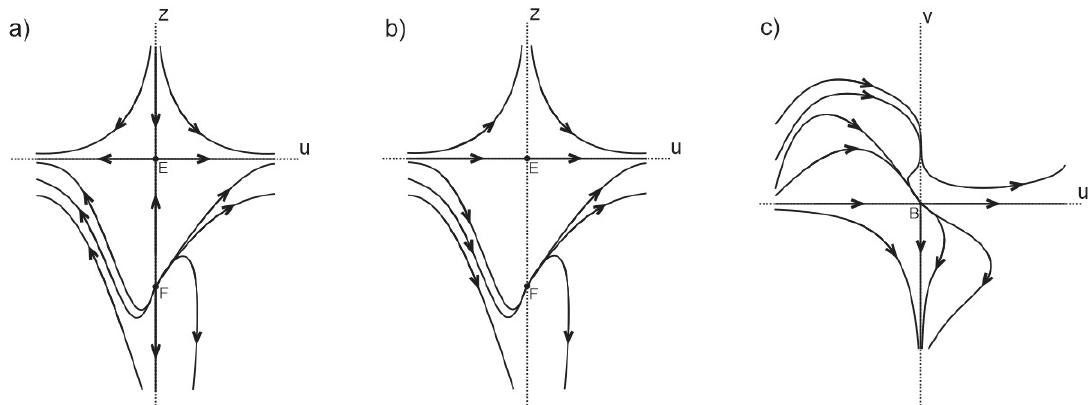
Figure 1. Step-by-step blow-down to distinguish behaviour near singular point B . ( a ) A neighborhood of the singular points of system (9). ( b ) After the multiplication by the common factor u the trajectories on u < 0 change direction. ( c ) A neighborhood of the singular point at the origin of system